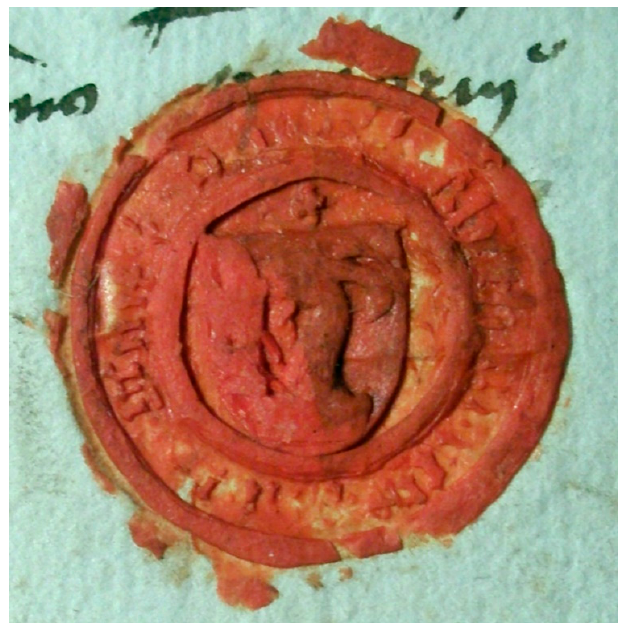
Figure 7. The seal of Queen Mother Elizabeth Szilágyi, from 1462. Archiv mesta Košice, Archivum Secretum, “F” Tellonium Nr. 63.